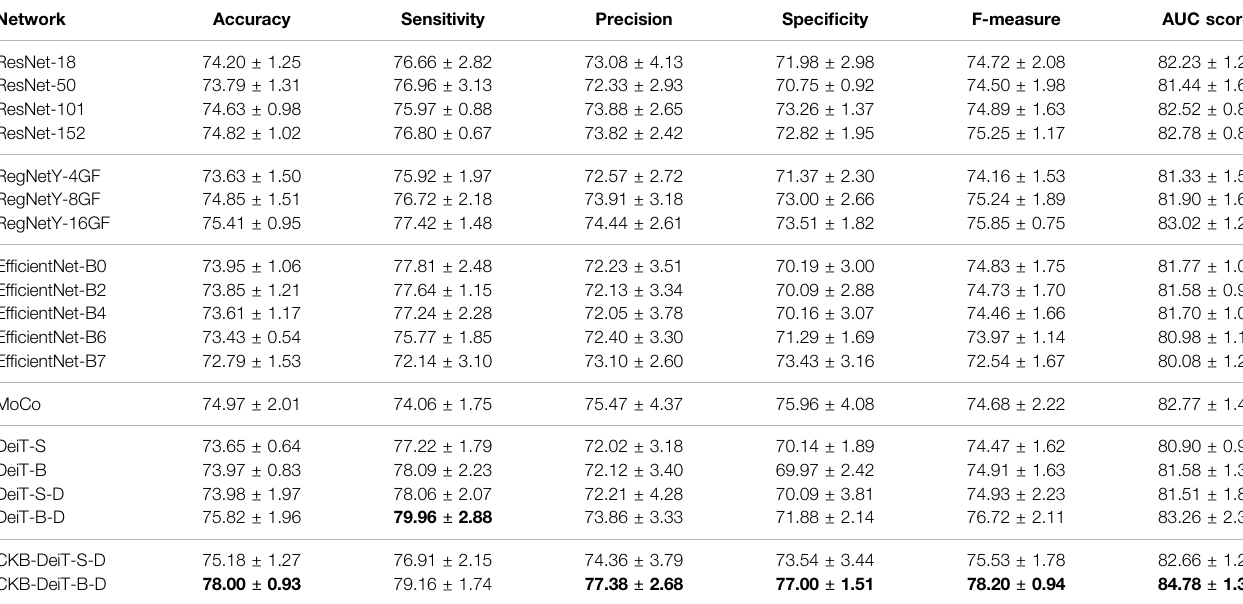
TABLE 1 | Performance of binary classi fi cation on the DFU infection dataset.